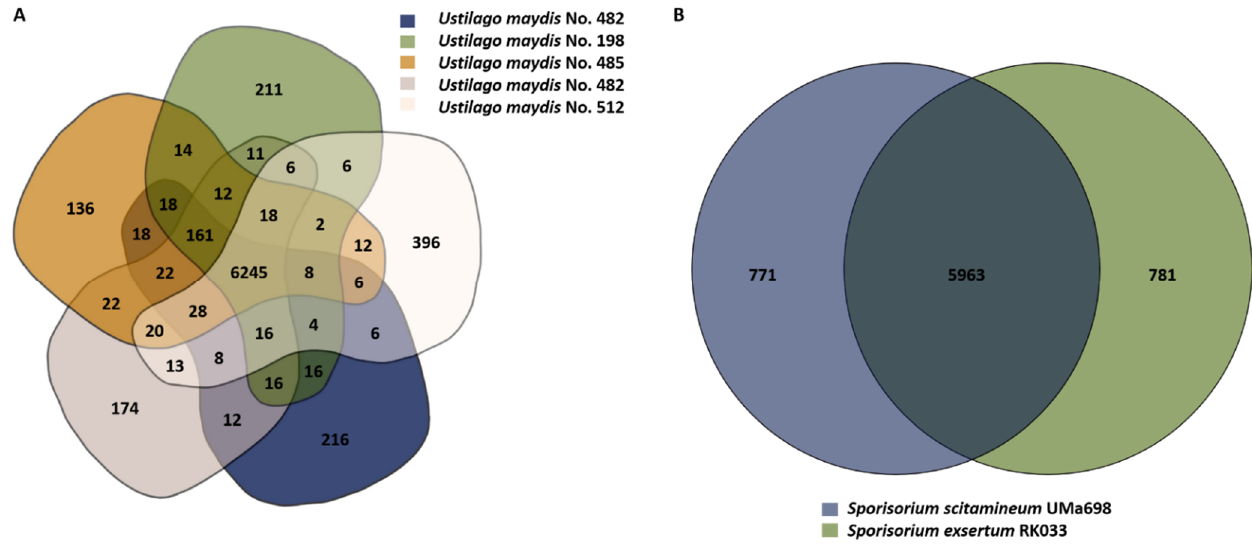
Figure 5. Gene-based comparison of Ustilaginaceae. Venn diagrams of ( A ): U. maydis and ( B ): Sporisorium isolates obtained from the comparative genomics tool EDGAR 3.0 [49]. Two isolates were sequenced in the case of U. maydis No. 482.